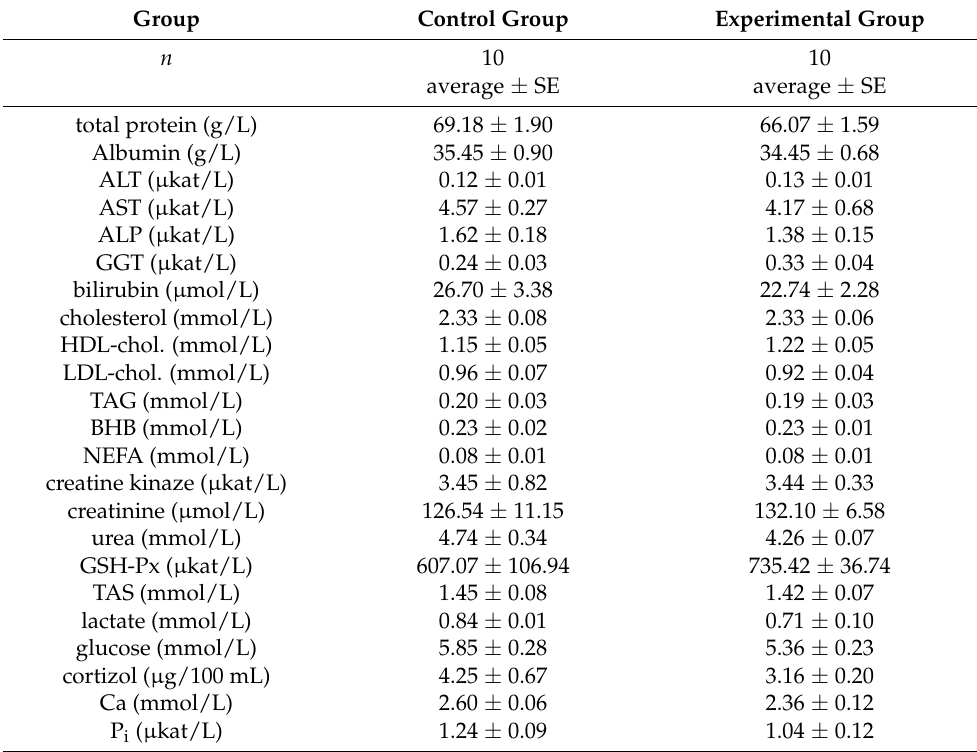
Table 3. Blood sample one: before the beginning of the experiment on day